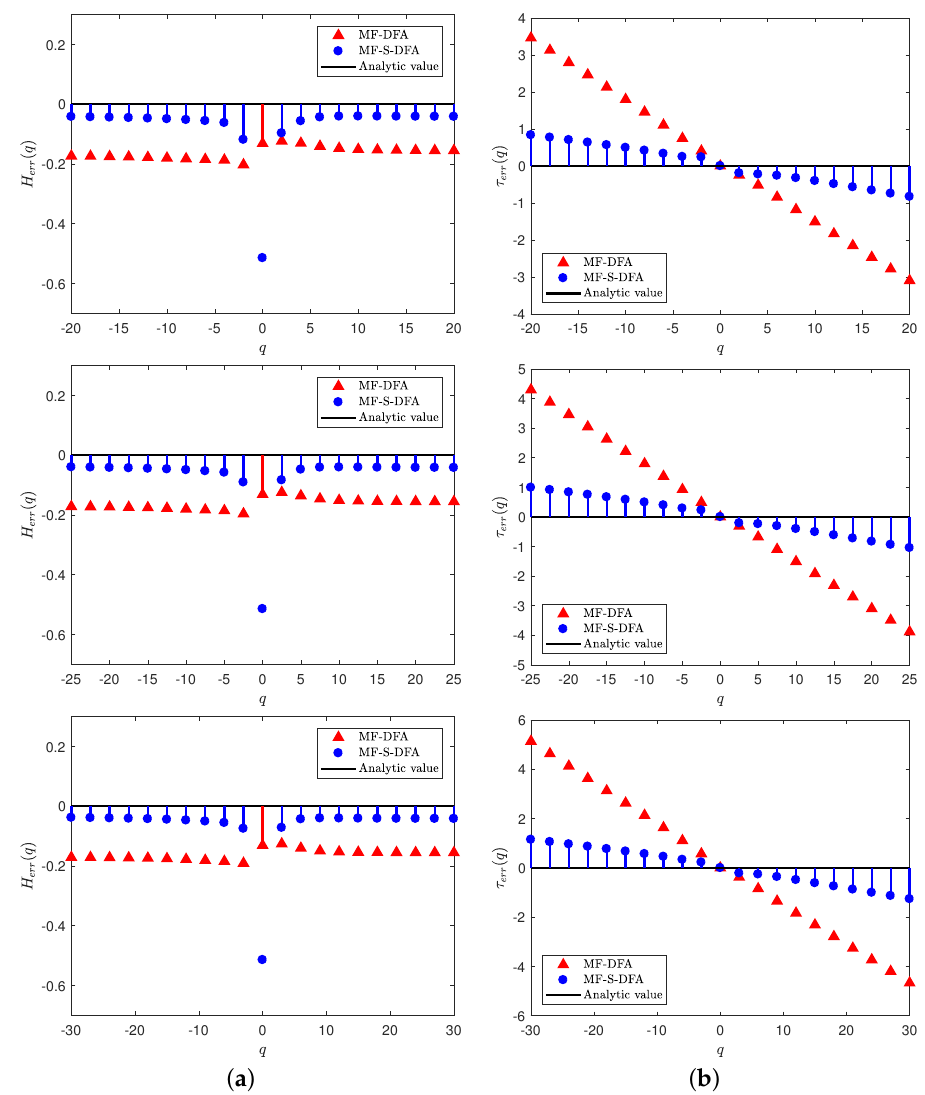
Figure 7. Comparison of MF-DFA and MF-S-DFA with theoretical values under different domains of q : ( a ) H err ( q ) and ( b ) τ err ( q ) . From top to bottom, q = [ − 5, 5 ] , [ − 10, 10 ] , [ − 15, 15 ] , [ − 20, 20 ] , [ − 25, 25 ] and [ − 30, 30 ] , respectively. A color version of the figure is available in the web version of the